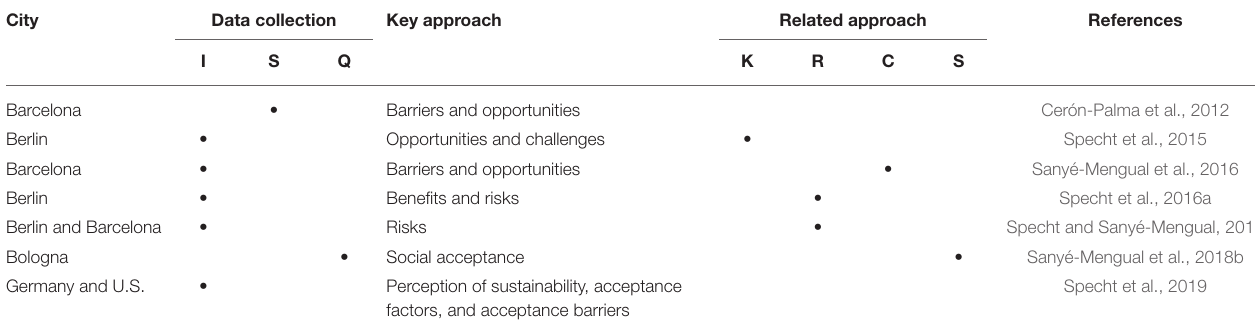
TABLE 1 | Studies of barriers and opportunities from stakeholders’